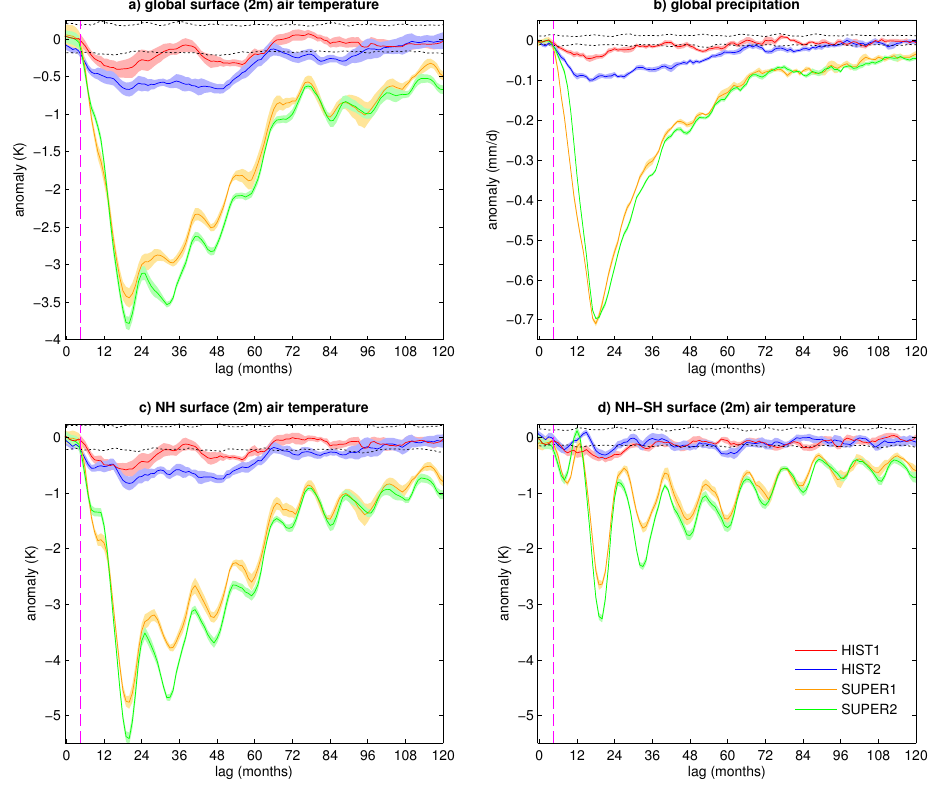
Figure 2. Simulated post-eruption anomalies of global-average surface (2m) air temperature (SAT) (a) and total precipitation (b) , northern- hemispheric average SAT (c) , and the difference between northern- and southern-hemispheric average SAT (d) for the two historical and the two supervolcano ensembles. Lines and shading represent the mean and the standard error of the mean respectively. Black dashed lines indicate the internal variability range ( n = 10; see methods). The dashed vertical magenta line indicates the approximate start of the eruptions. Lag(0) corresponds to January of the eruption year. Note that the y axis in panels (c) and (d) has the same scale, highlighting the relative magnitude of inter-hemispheric differences in the temperature